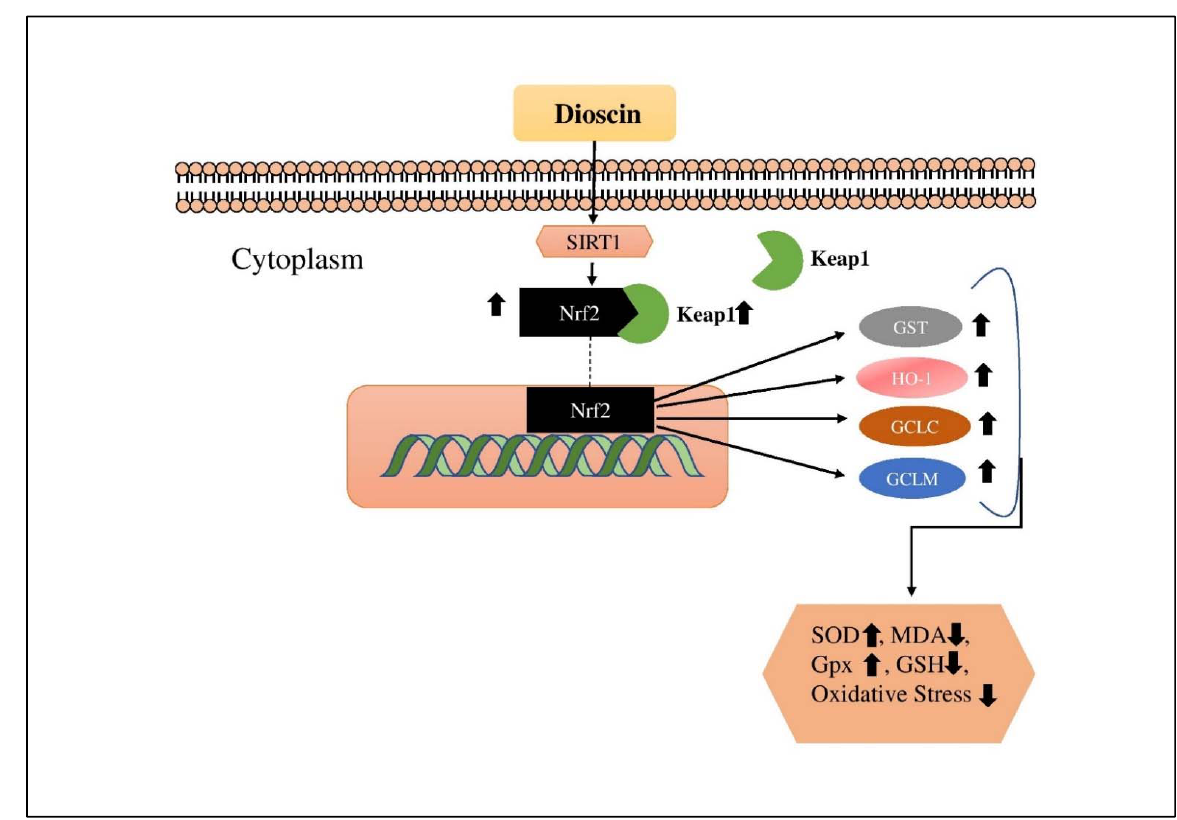
Figure 7. Mechanism of Nrf2-ARE activation by DC. The diagram was adapted and modified from Zhang, X. et al., 2015 [224].